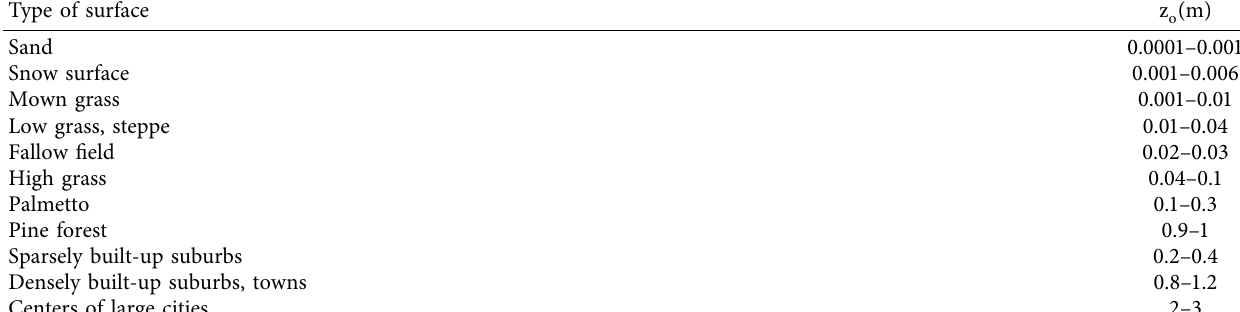
Table 1: Values of surface roughness length for various types of built-up terrain.